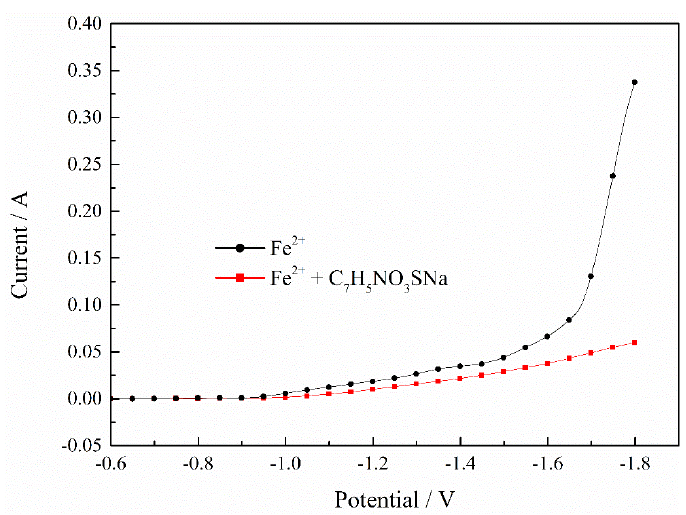
Figure 5. Effect of C 7 H 5 NO 3 SNa on deposition process of Fe 2+ . pH = 2, T = 30 °C.